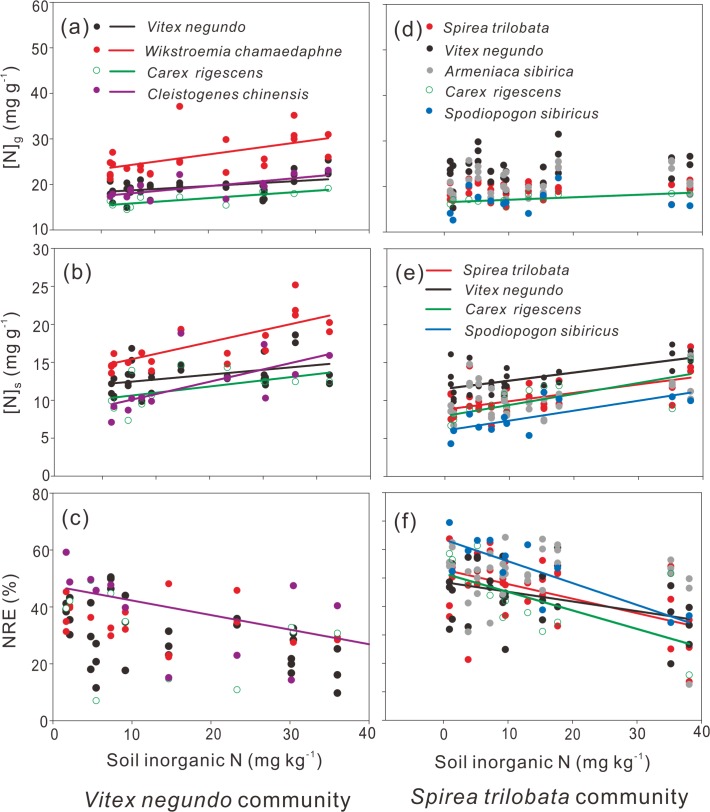
Changes of N concentration in green ([N]g), senescing leaves ([N]s) and nitrogen resorption efficiency (NRE) with soil inorganic N in the Vitex negundo (left, a, b and c) and Spirea trilobata (right, d, e and f) communities.The solid lines indicate significant linear regression at p< 0.05.